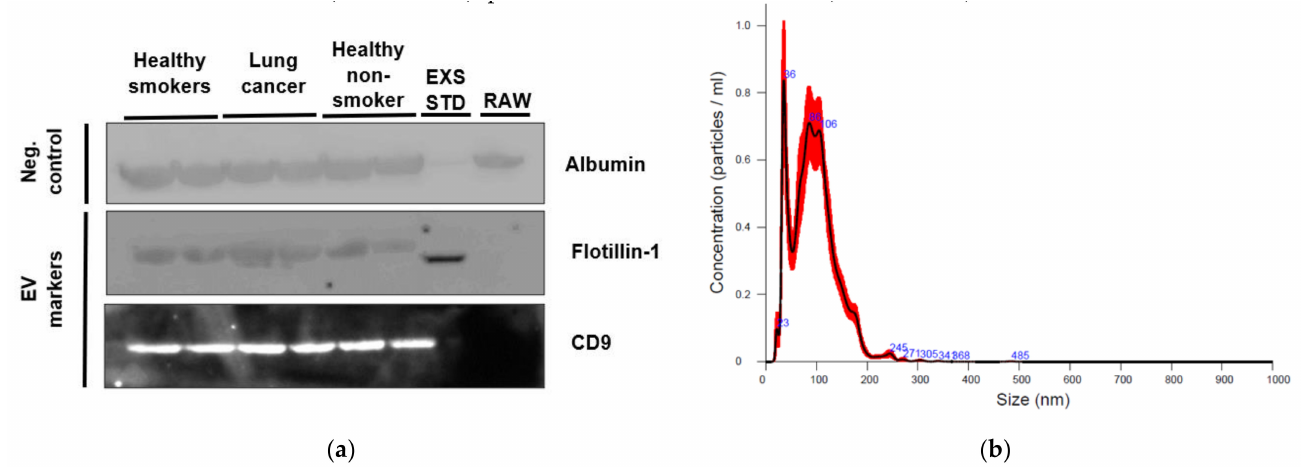
Figure 1. Plasma derived EV characterization. ( a ) Western blot of negative control marker Albumin and EV markers Flotillin-1 and CD9 presence or absence in participant groups (healthy smokers, lung cancer, healthy non-smokers), as well as lyophilized exosome standard from plasma (EXS STD) and raw plasma (RAW). ( b ) Plasma EV particle concentration and size from a healthy non-smoking participant using nanoparticle tracking analysis